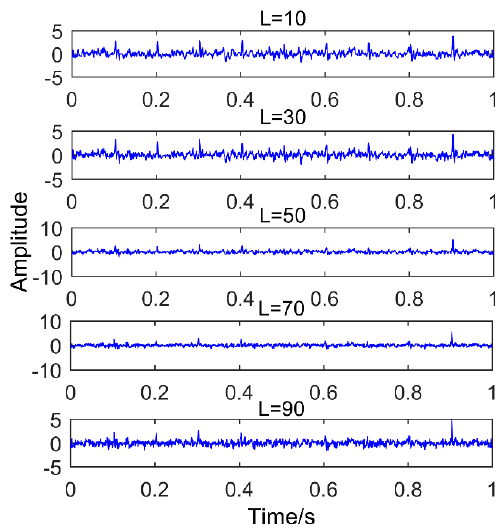
Figure 10. Results obtained by MEDA for processing the signal when changing the length of filter.